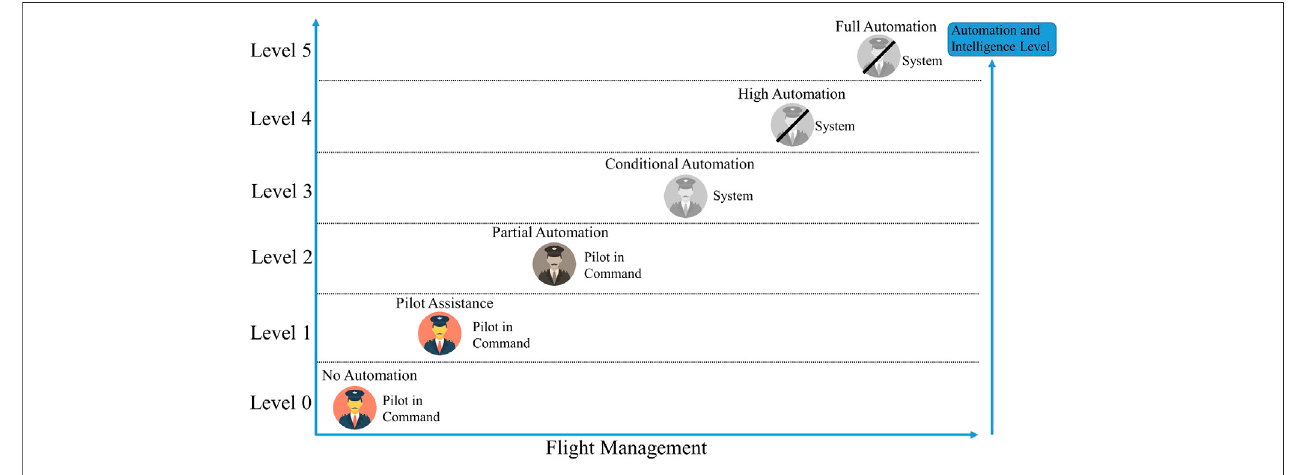
FIGURE 9 | Automation level of UAV (Giordani and Zorzi,